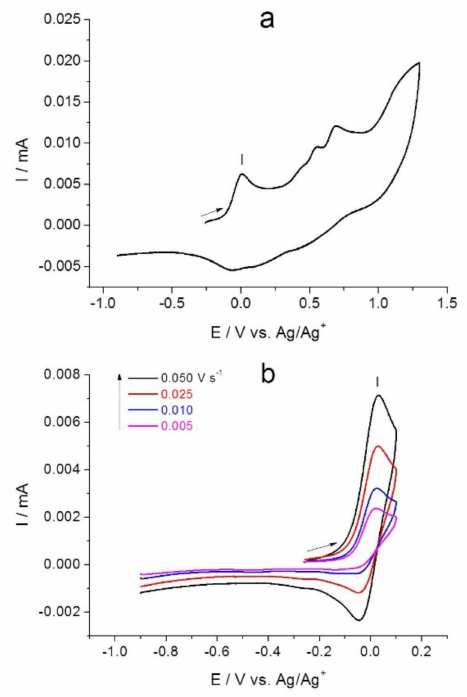
Figure 3. Cyclic voltammograms of a glassy carbon electrode (0.07 cm 2 ) in 0.001 mol L − 1 solution of [NiAmben] in 0.1 M Et 4 NBF 4 /EC/DEC (50:50 v / v ): ( a ) between − 0.9 and 1.3 V at a scan rate of